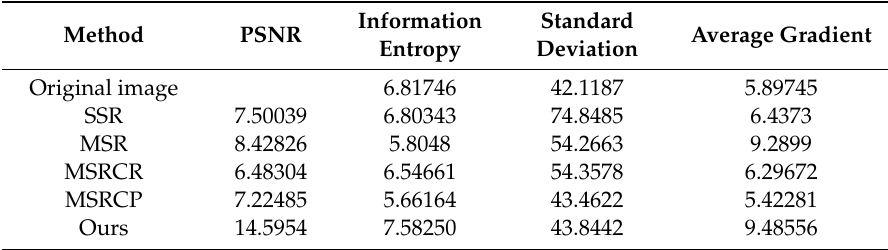
Table 1. Objective Evaluation Index of Image Enhancement Algorithms.